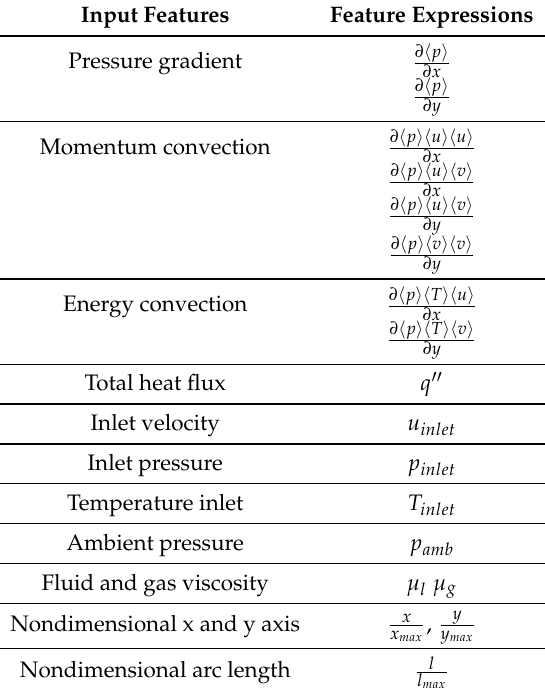
Table 2. Input features used for training the network.